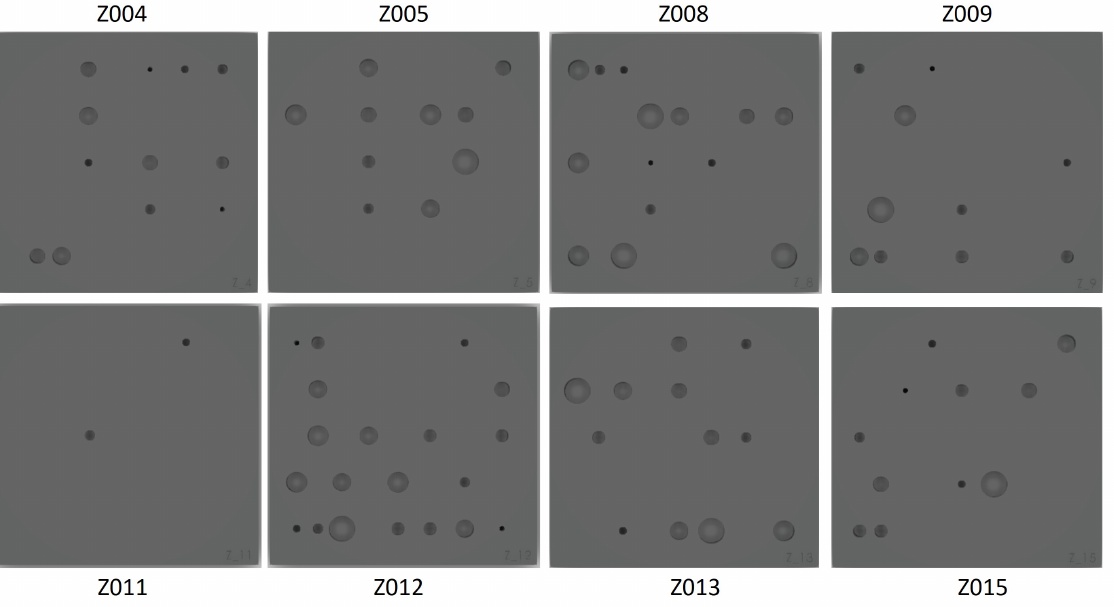
Figure 2. Visualization of eight specimens from the bottom